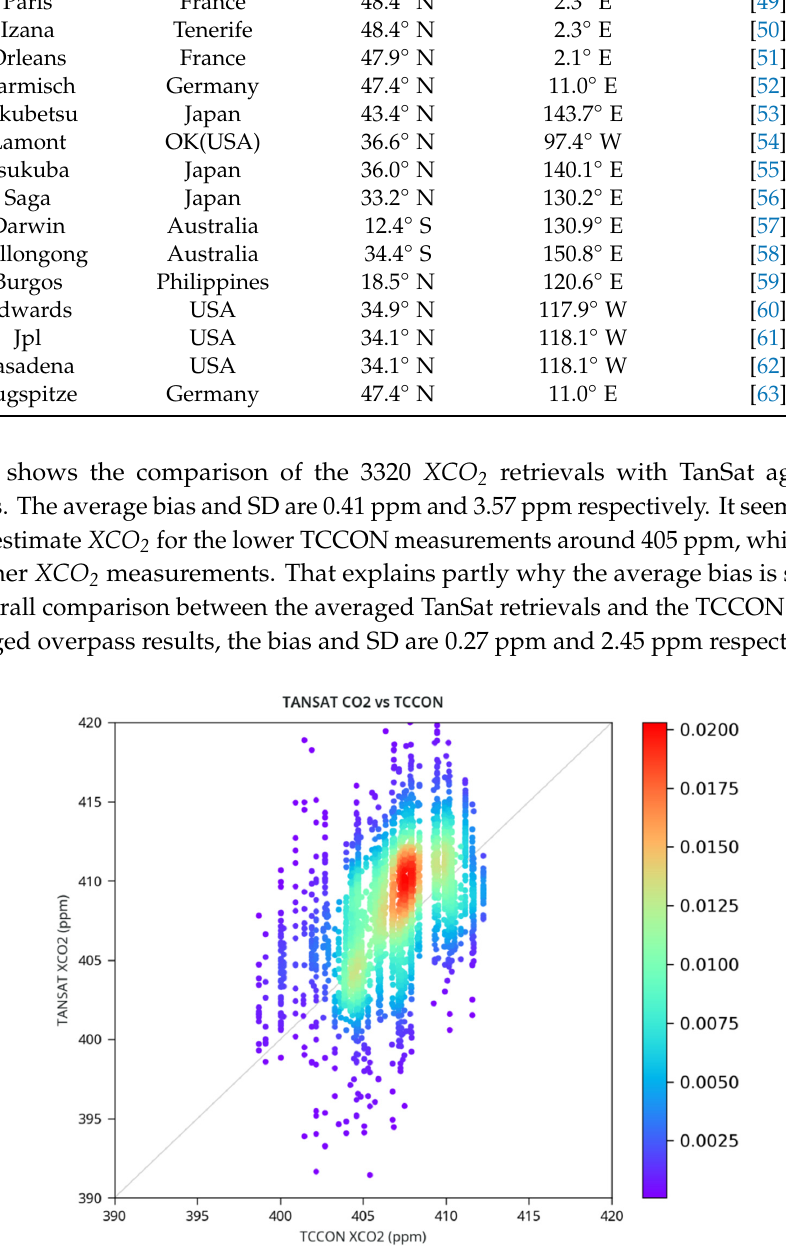
Figure 3. Validation of the averaged XCO 2 retrieved from TanSat nadir measurements with collocated TCCON data. The SD of the XCO 2 retrievals corresponding to each TCCON measurement scene is presented with the length of bar.